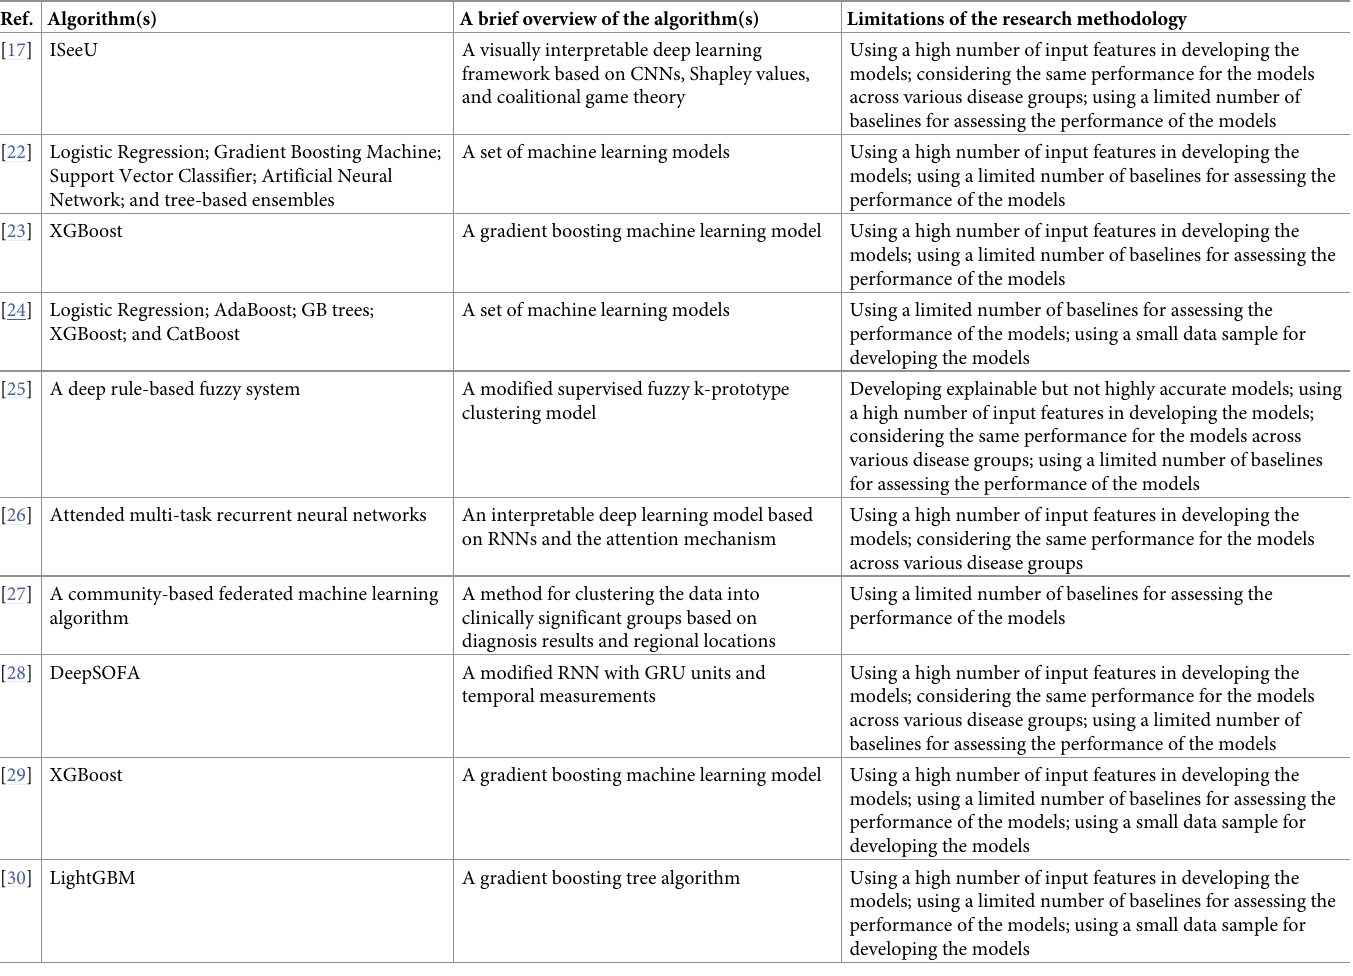
Table 1. A methodological overview of the related